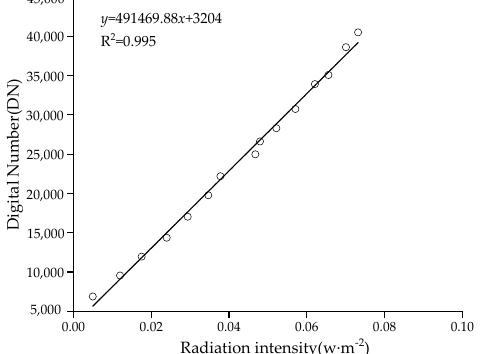
Figure 12. The relationship between the DN of the image display and the 840 nm infrared radiation intensity.